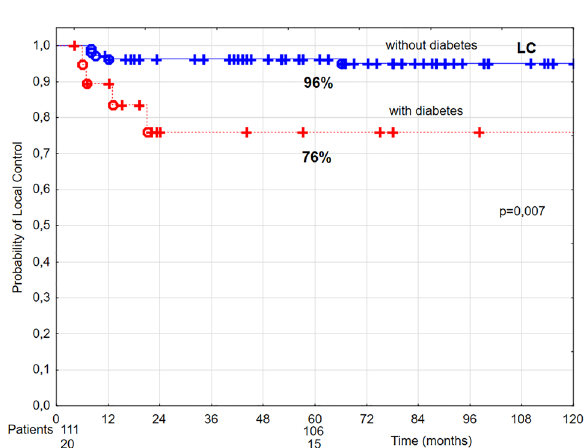
Figure 6. The probability of 5-year local control (LC) in T1 glottic cancer patients aged 70 and above in relation to